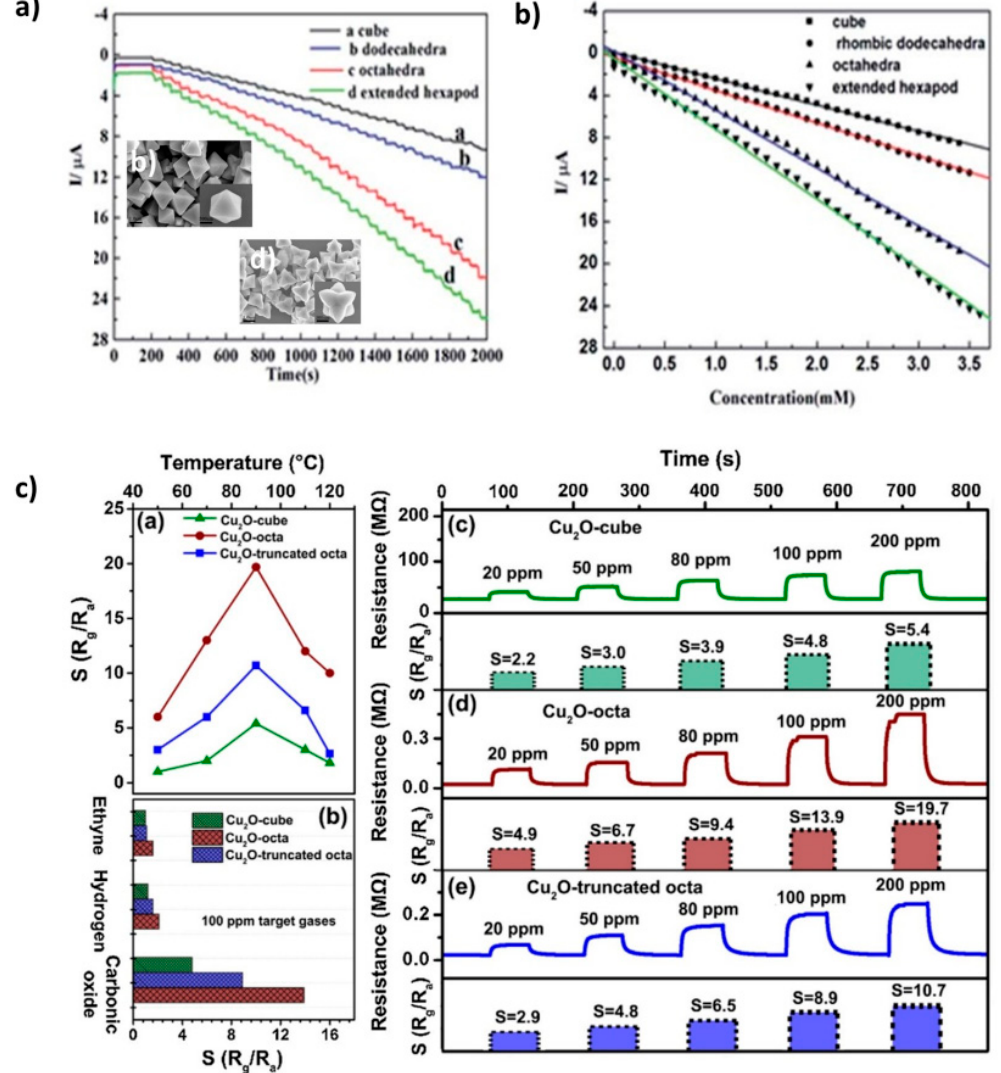
Figure 11. Amperometric response of four different Cu 2 O modified electrodes ( a ) with the corresponding calibration curves of oxidation currents versus H 2 O 2 concentrations ( b ). Reprinted and modified with permission from ref. [146] The relationship of working temperature and sensing response of various shaped Cu 2 O towards CO, H 2, and C 2 H 2 with dynamic curves and gas response values ( c ). Reprinted with permission from ref. [33].